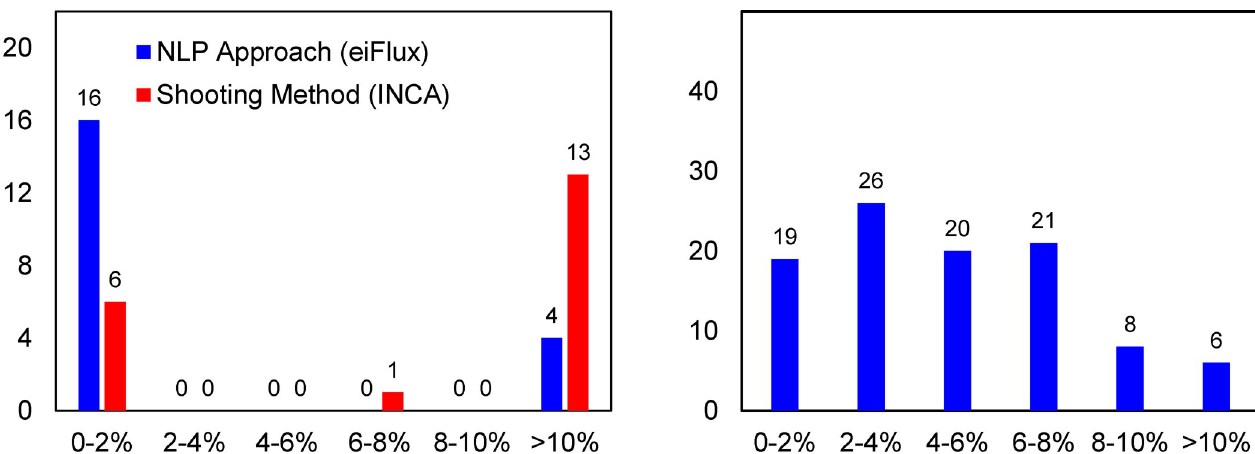
Fig 7. (Left) Number of restarts out of 20 that converged within a vicinity (percent) of the best-computed optimum for the NLP approach and the shooting method. For the NLP approach, these 20 restarts were performed with the 3rd-order Radau IIA method followed by refinement using the 9th-order method. The best achieved optimum was 660.39 with the 3rd-order method and 644.14 after the 9th-order refinement. For the shooting method we used the software INCA, and the best achieved optimum was 646.34. (Right) Results from 100 restarts for the genome-scale Synechocystis example. Using the NLP approach, most optimizations started from a random initial point converge to within 10% of the best-computed optimal solution, and a large fraction within 2%. This highlights the robustness of the NLP approach for inst-MFA